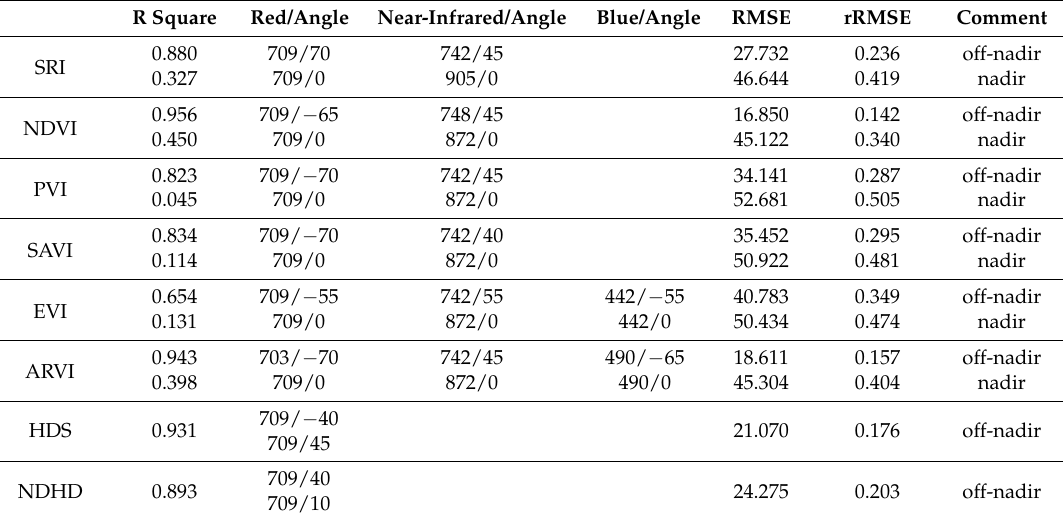
Table 5. Comparison of nadir with off-nadir using the